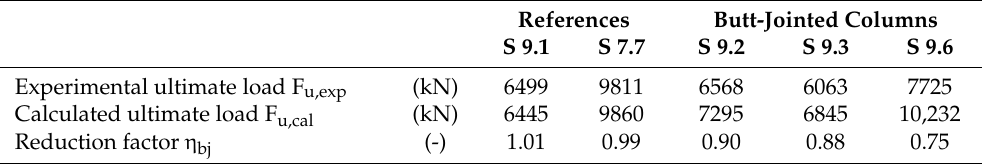
Table 2. Comparison of experimentally and mathematically determined ultimate loads.